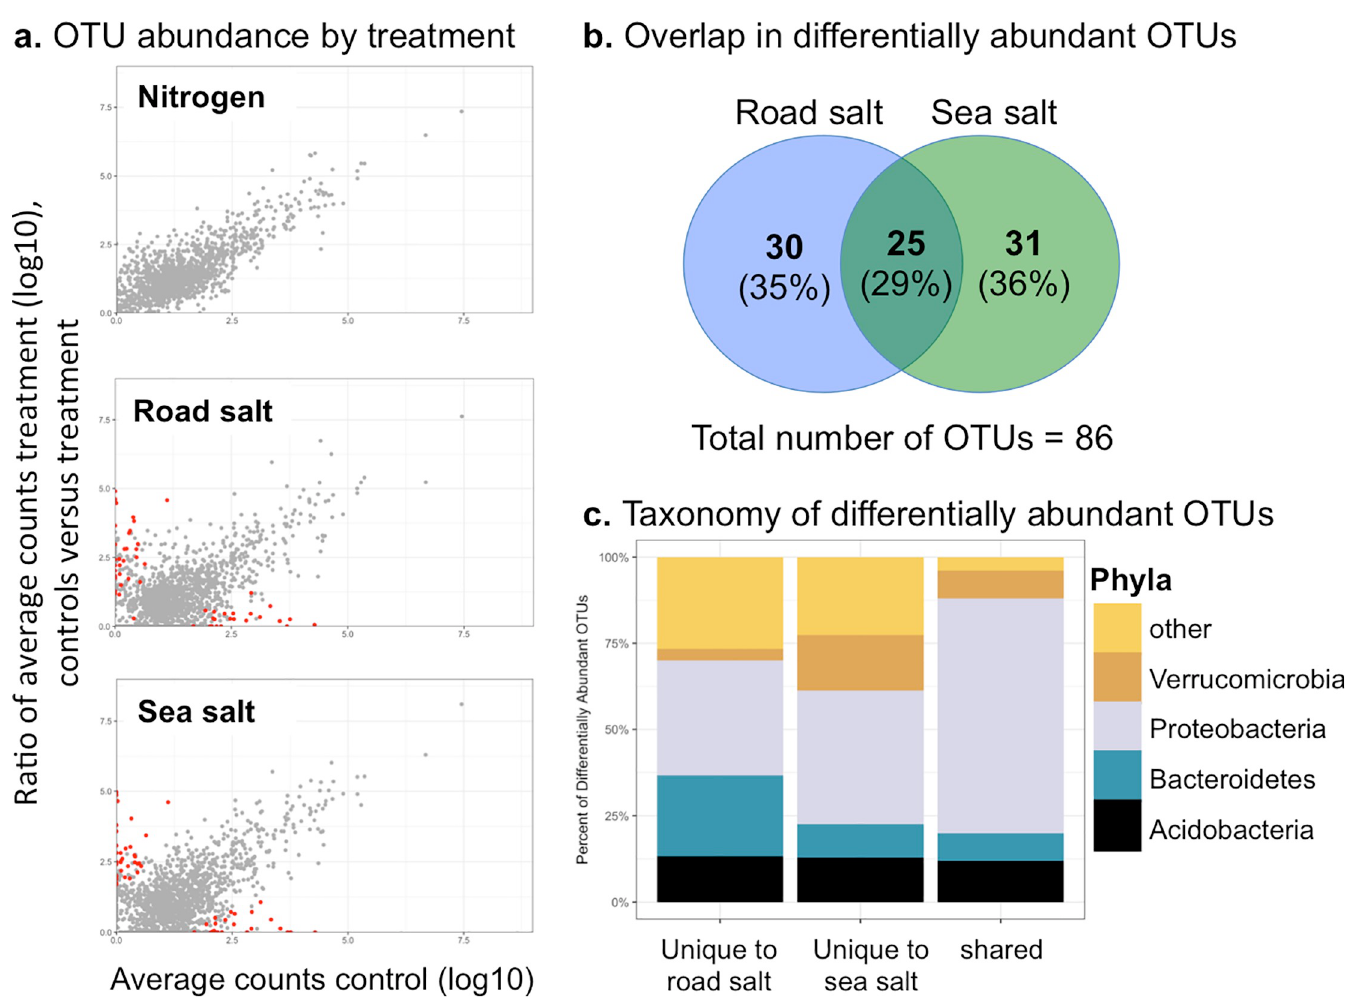
Fig 8. Differentially abundant OTUs due to water quality treatment. (a) Each point represents a detected OTU and its counts in controls versus treatment. OTUs colored in red were identified as significantly different in abundance. (b) Differentially abundant OTUs unique and shared among the two salt treatments, (c) Taxonomic classification of differentially abundant OTUs in salt